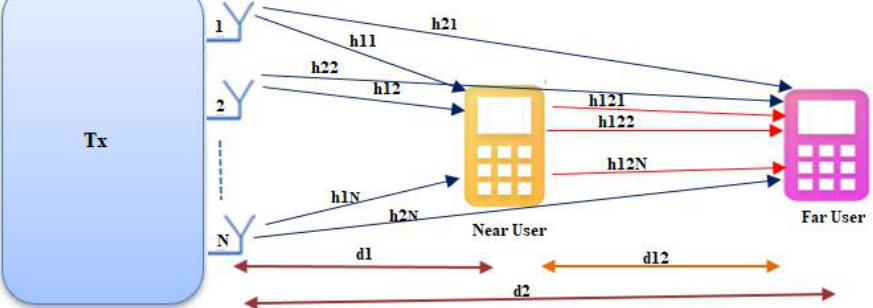
Figure 3. Downlink transmission for the cooperative NOMA network combined with a 16 × 16, a 32 × 23, and a 64 × 64 MIMO.